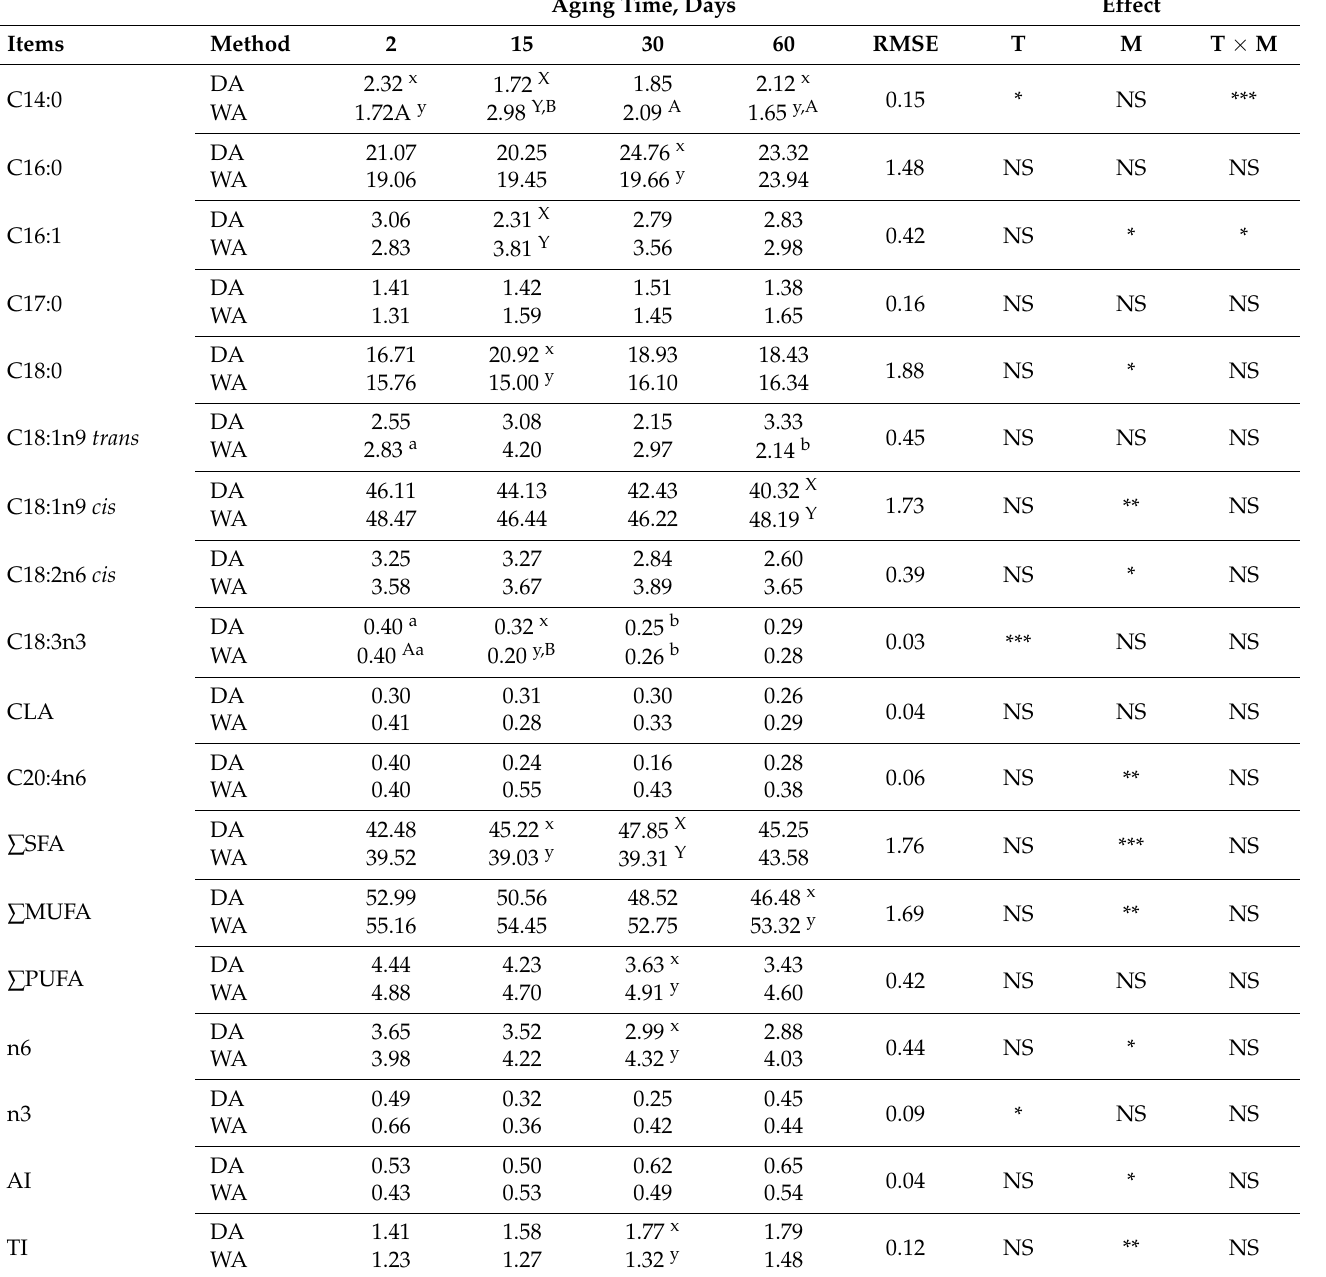
Table 5. Changes in the fatty acid composition of meat as a function of the aging method and time in Charolais meat cuts ( Longissimus dorsi (LD) and Semitendinosus (ST)) aged by different methods (dry-aging (DA) and wet-aging (WA)) for 60 days. Aging Time, Days